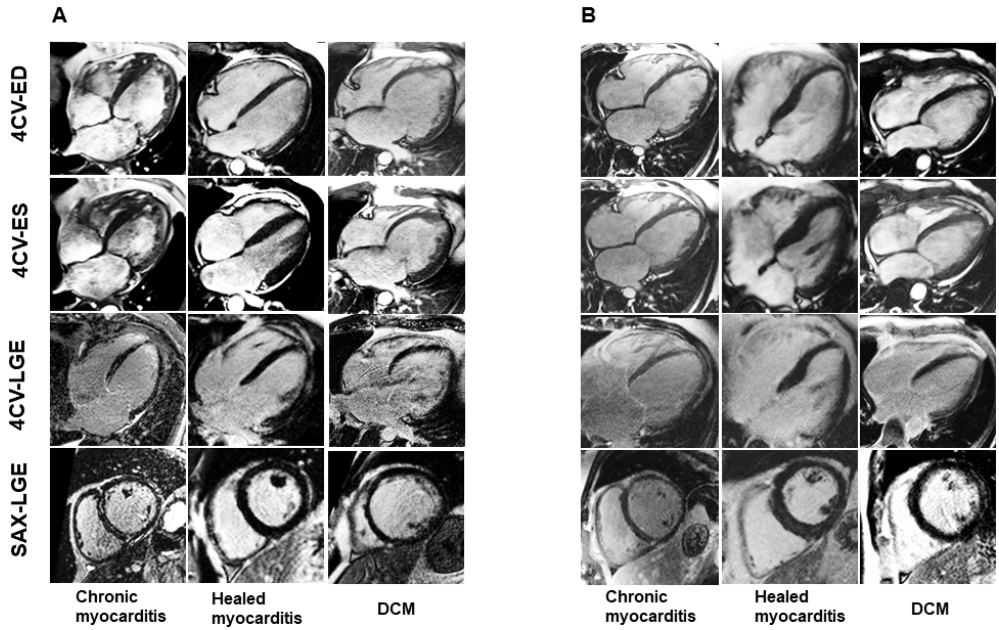
Figure 3. CMR examples of chronic healed myocarditis and DCM: different phenotypes. ( A ) Representative Cine and LGE data of patients with chronic, healed myocarditis and DCM. ( B ) Other examples of chronic, healed myocarditis and DCM show a similar appearance in CMR. DCM: dilated cardiomyopathy, 4CV-ED: end-diastolic four-chamber view, 4CV-ES: end-systolic four-chamber view, 4CV-LGE: late gadolinium enhancement four-chamber view, SAX-LGE: late gadolinium enhancement short axis view .